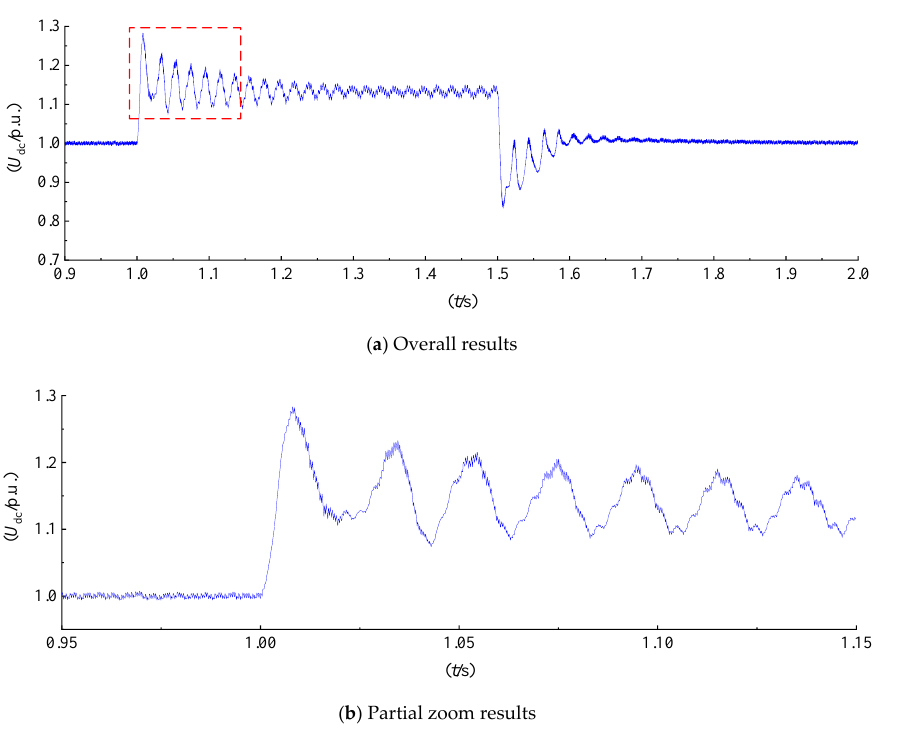
Figure 3. DC bus voltage under traditional control strategy.